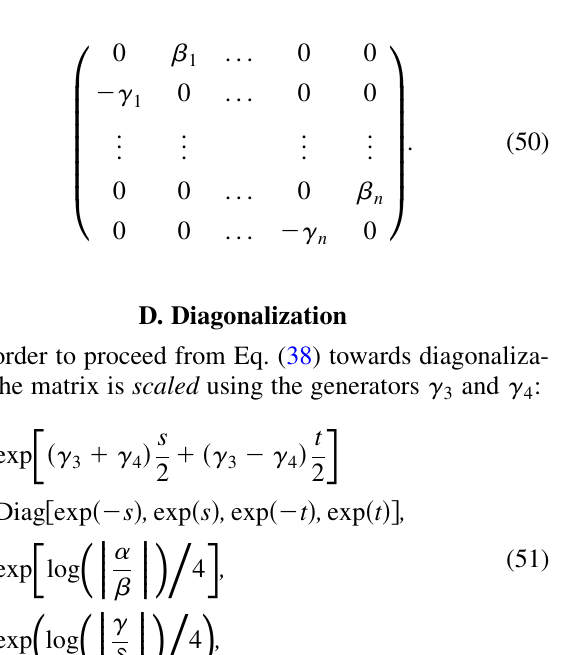
. The number n of b 2 ¼ n ð n (cid:1) 1 Þ b 2